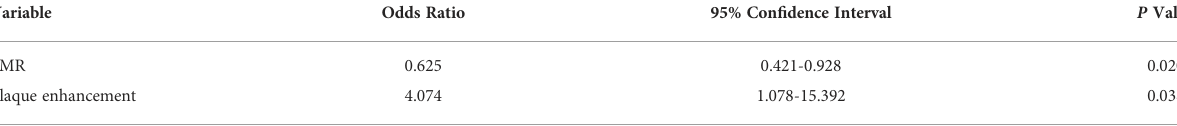
TABLE 4 Forward multiple logistic regression analysis of symptomatic stenosis.